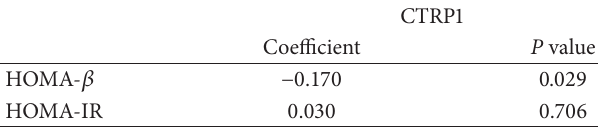
Table 4: Pearson’s correlation coefficient between circulating Table 2: Correlation between circulating CTRP1 and fasting blood CTRP1 levels and clinical data in univariate glucose levels. CTRP1 † Coefficient P value Glucose 0.310 0.000 † Ln transformed. BMI, age, sex, and medications were controlled variables and medications included are SU, glinide, AGI, DPP-IV inhibitor, insulin, ACE inhibitor, ARB, CCB, thiazide, 𝛽 -blocker, statin, fenofibrate, cilostazol, and thioctic acid. Table 3: Pearson’s correlation coefficient of CTRP1 with HOMA- 𝛽 and HOMA-IR. CTRP1